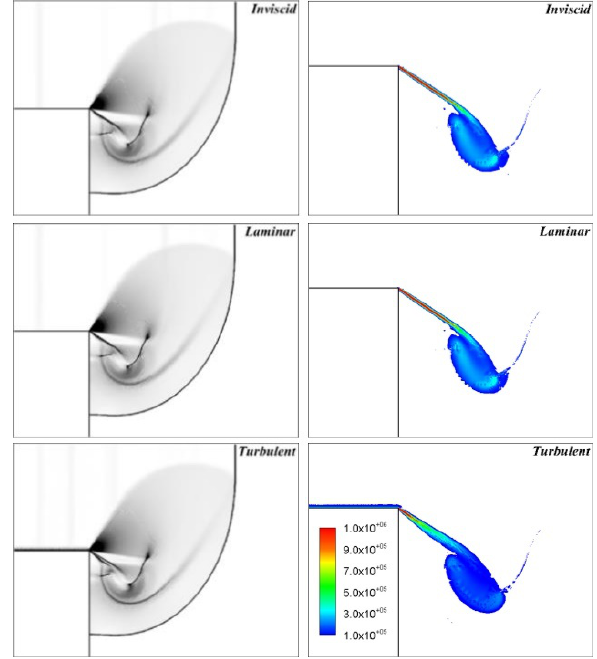
Fig. 4. Schlieren (left) and vorticity (right) of shock wave diffraction over the backward-facing step for different solvers.